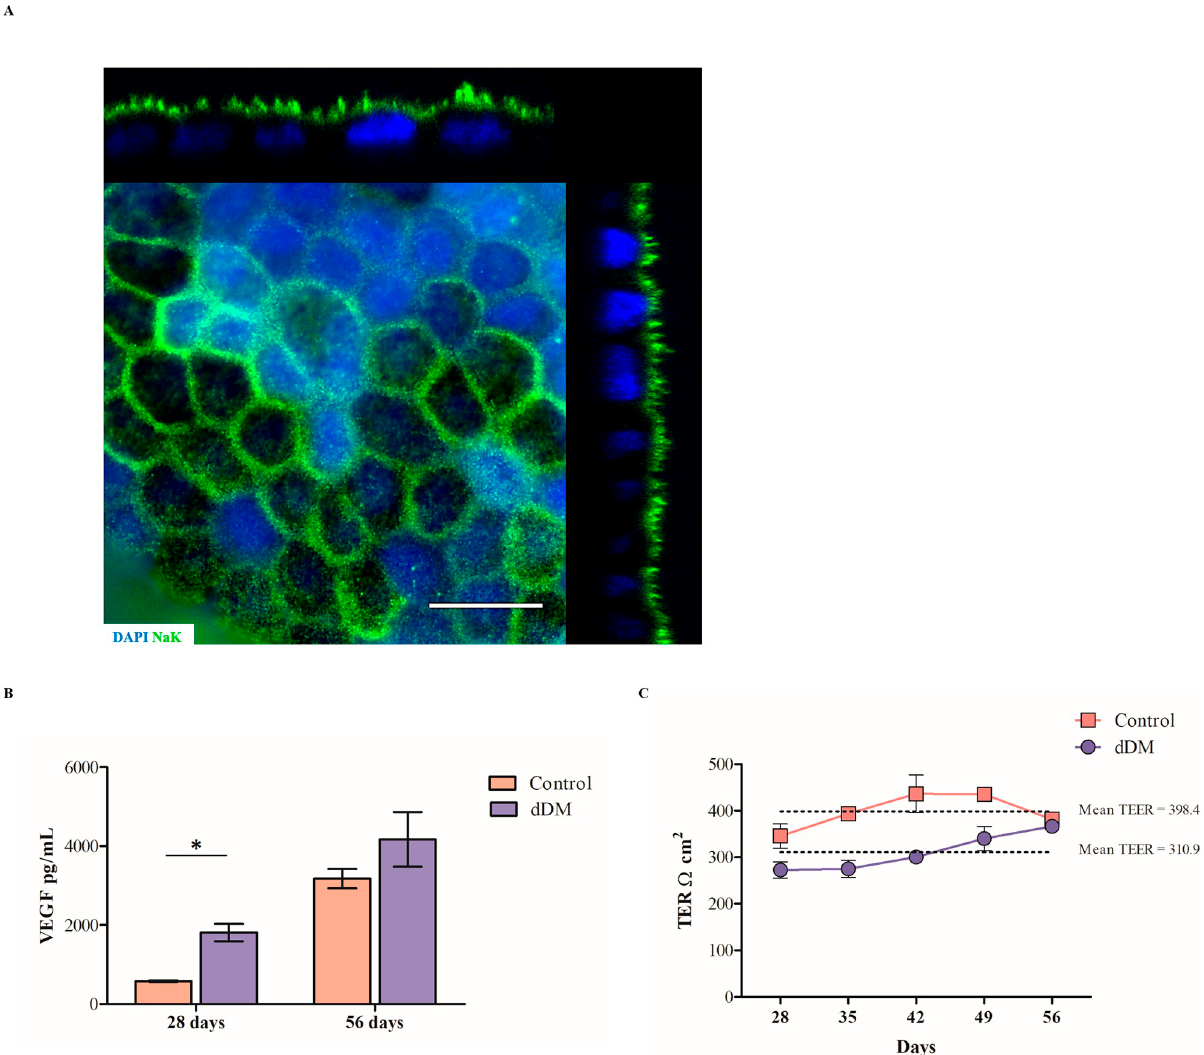
Fig 6. hESC-RPE cells monolayer evaluation over the natural scaffold. ( A ) Na + /K + ATPase immunostaining shows proper polarization of the cells when cultured on dDM. Scale bar = 100 μ m. ( B ) ELISA assay was used to quantify VEGF secretion in spent medium from hESC-RPE cells cultured on dDM. VEGF levels were then compared with the amount of VEGF secreted by control on pre-coated TC insert. Values are given as the mean ± s.d. for triplicate experiments. � p = 0.016. ( C ) TER measurements of hESC-RPE cell sheets on dDM at 1 month after seeding, indicating an increase in resistance following proper tight junction development. Each line represents records from four separate cultures of hESC-RPE cells grown on dDM and on TC inserts, respectively. dDM, denuded Descemet’s membrane; NaK, Na + /K + ATPase; TER, transepithelial resistance.